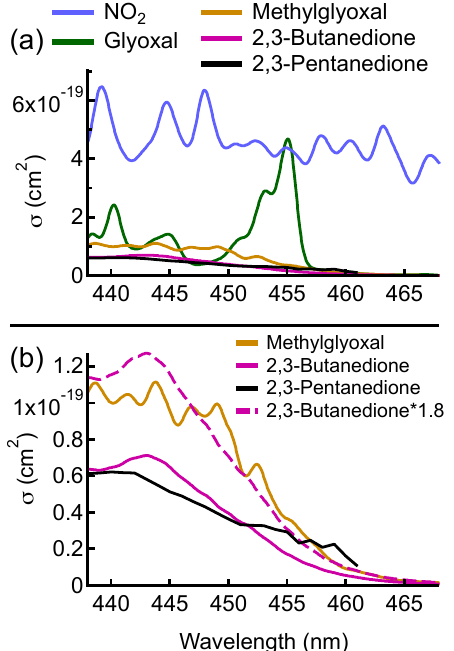
Figure 7. (a) Absorption cross sections for NO 2 (Vandaele et al., 1998), glyoxal (Volkamer et al., 2005), methylglyoxal (Meller et al., 1991), 2,3-butanedione (Horowitz et al., 2001), and 2,3- pentanedione (Messaadia et al., 2015) in the ACES fit window. (b) Absorption cross sections of methylglyoxal, 2,3-butanedione, and 2,3-pentanedione (solid lines), and the absorption cross section of 2,3-butanedione scaled by a factor of 1.8 (dashed line) to bet- ter show the similarity in the shape of that cross section with the methylglyoxal cross section. All the cross sections shown are con- volved to the instrument resolution of 1nm (FWHM).